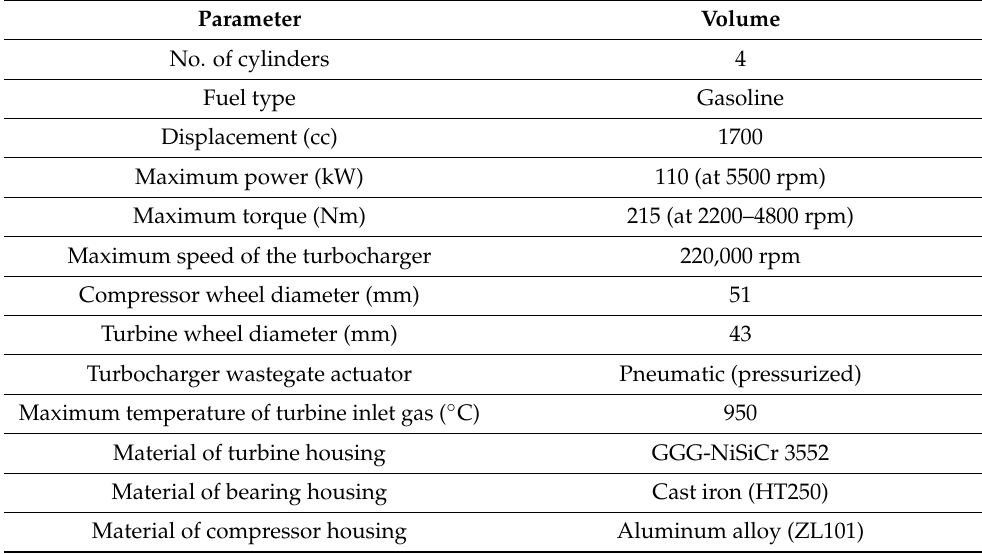
temperature stabilized. The location of the camera inside the engine test cell is shown in Figure 7. The camera shows the turbine housing and the catalyst, which are the hot parts of the engine. The appropriate emissivity of the housing was applied. The temperature and humidity of the test cell were determined by the test cell sensors. Each test was repeated three times to ensure the repeatability of the